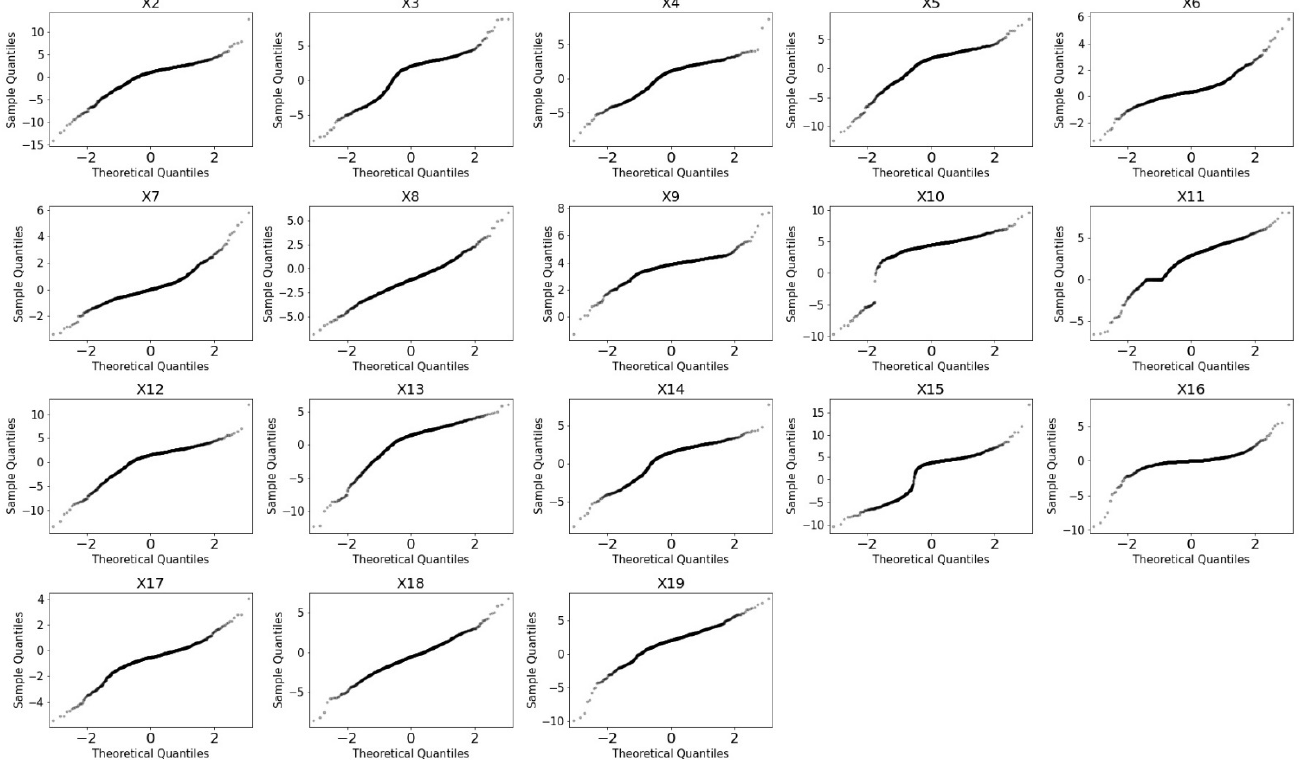
Figure 3. Quantile–quantile plots of continuous independent variables after transformation according to Formula (1).